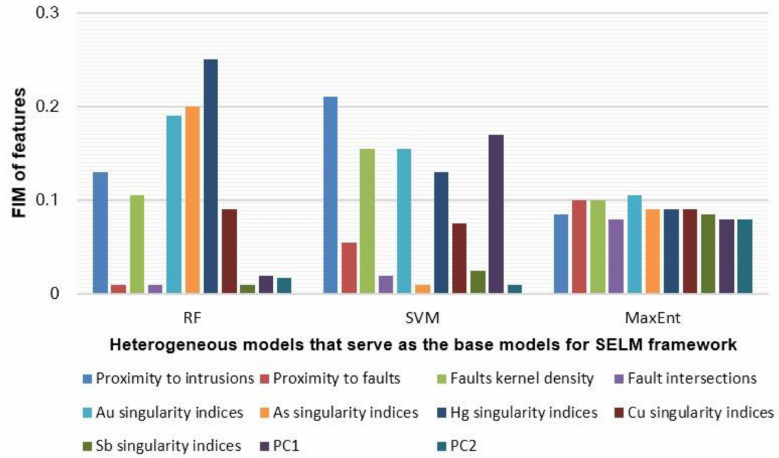
Figure 10. Feature importance measures (FIMs) of mineralisation influencing factors using di ff erent